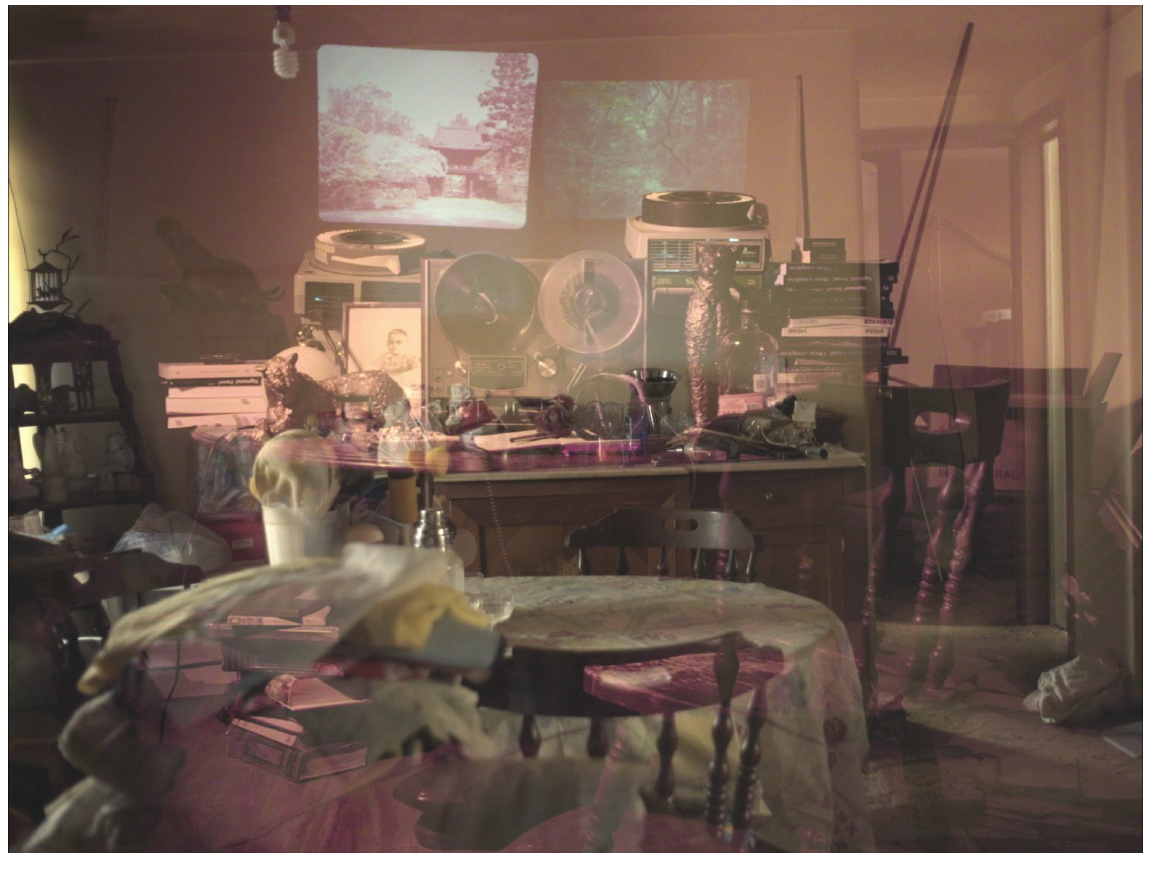
Figure 1. Still from To Remember: An exercise into the decolonisation of the filmmaker’s unconscious (Source: Emilio Reyes